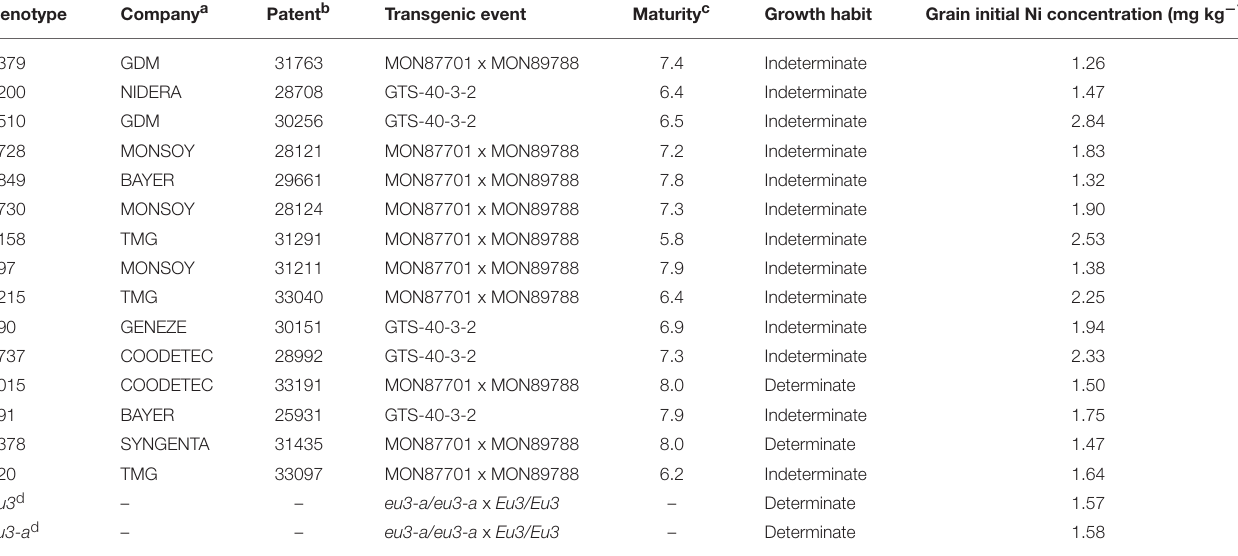
TABLE 1 | Summary of characteristics for 15 soybean genotypes and two near-isogenic lines with urease-positive ( Eu3 ) and urease activity-null ( eu3-a ). Genotype